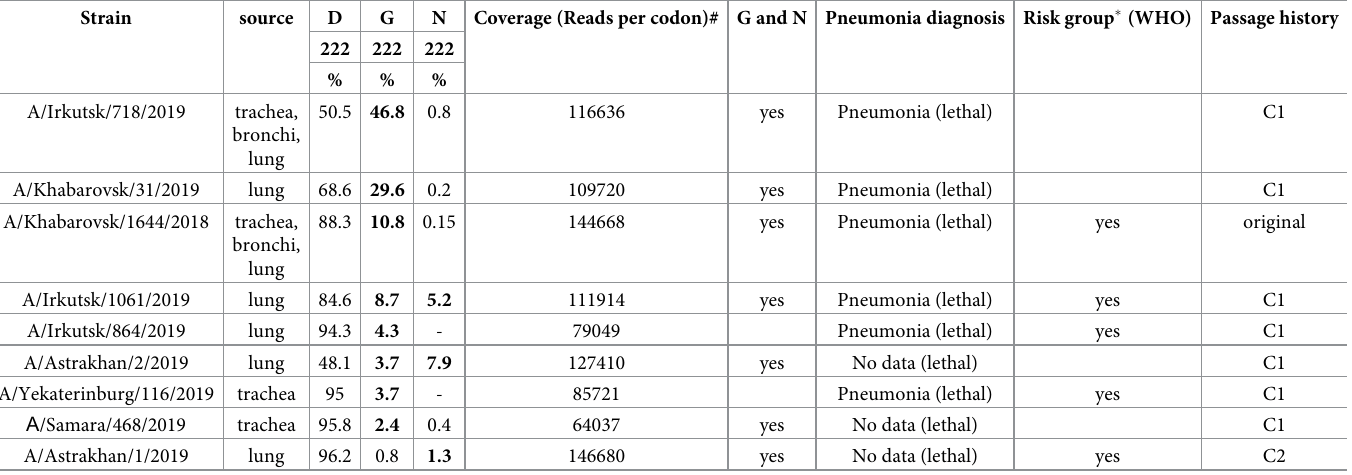
The table shows the percentage of virus variants with the mutations in the